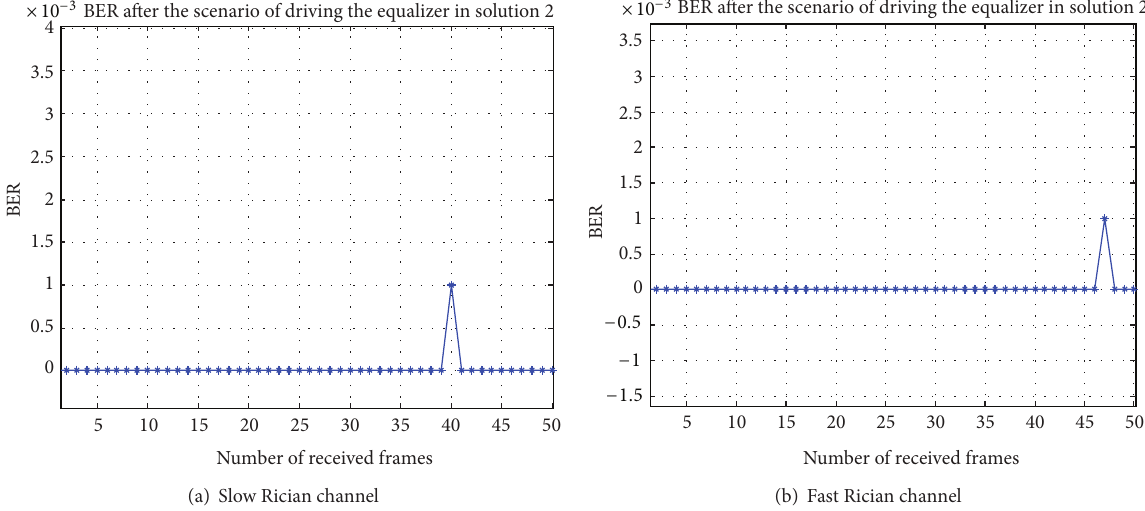
F 9: Performance of the system aer decision making for the Rician channel with solution 2: no errors of the equalizer; the BER is always −3 < 10